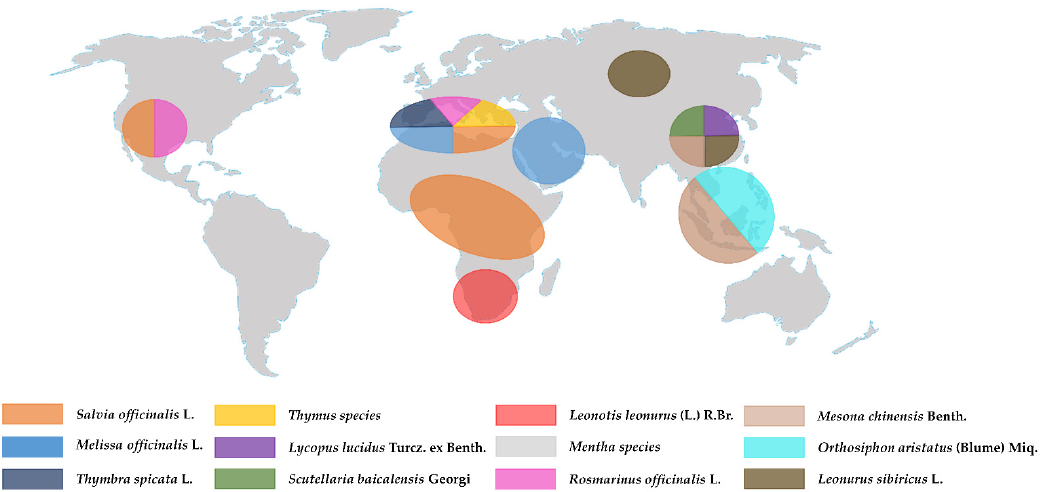
Figure 1. Geographical representation of the worldwide distribution of different Lamiaceae plants.